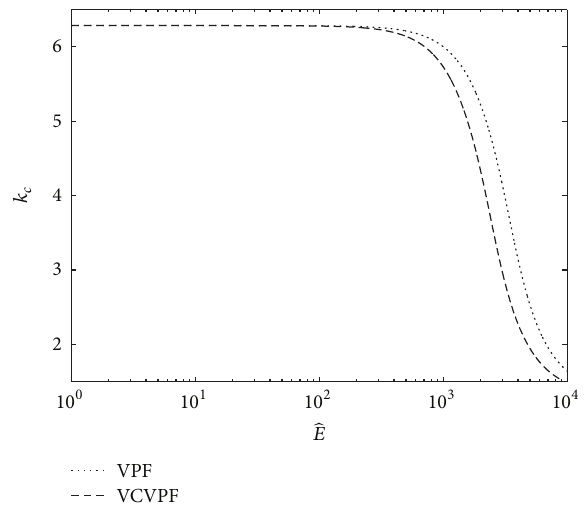
Figure 5: Comparison between the neutral curves for critical wave number obtained for VPF as well as VCVPF analysis when Λ = 10 −5